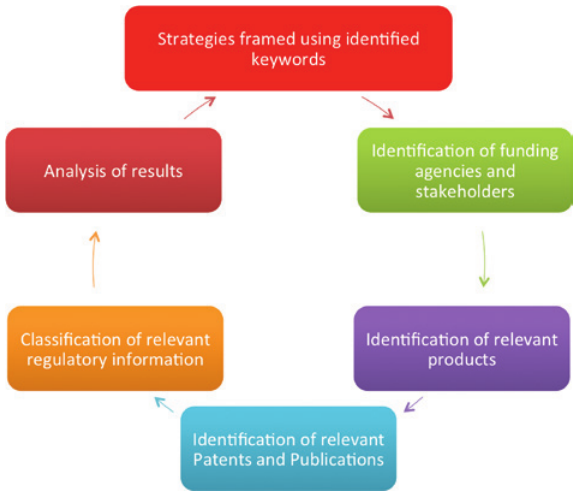
Figure 2: Methodology adopted for mapping nanomedicine innova- tion landscape in